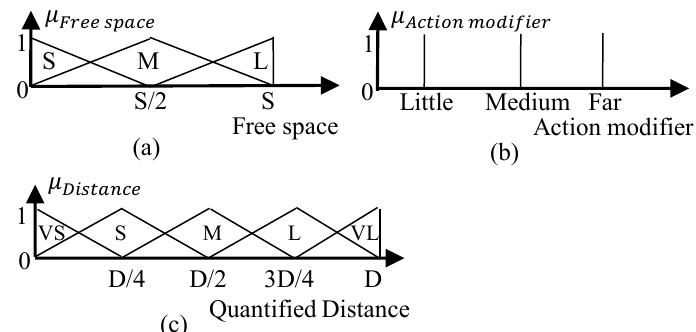
Figure 2. ( a , b ) represent the input membership functions of the uncertain information understanding module (UIUM). ( c ) represents the output membership function of the UIUM. The membership functions are defined similarly to the system explained in [20]. The fuzzy labels are defined as S: small; M: medium; L: large; VS: very small and VL: very large.